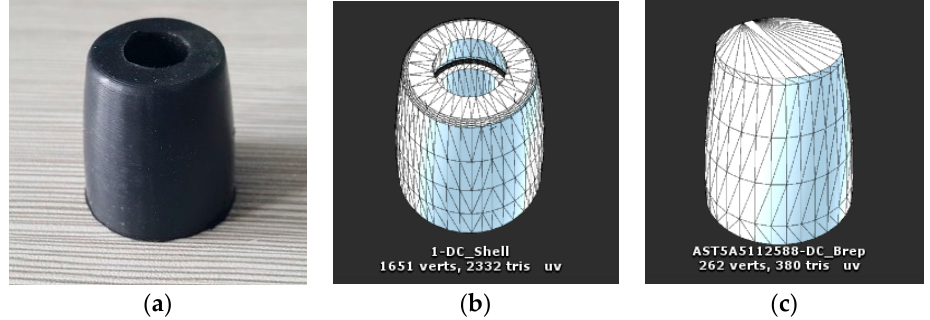
Figure 25. Simplified model of the roller in Unity3D: ( a ) the picture of the roller; ( b ) mesh model of the roller; ( c ) simplified mesh model of the roller.